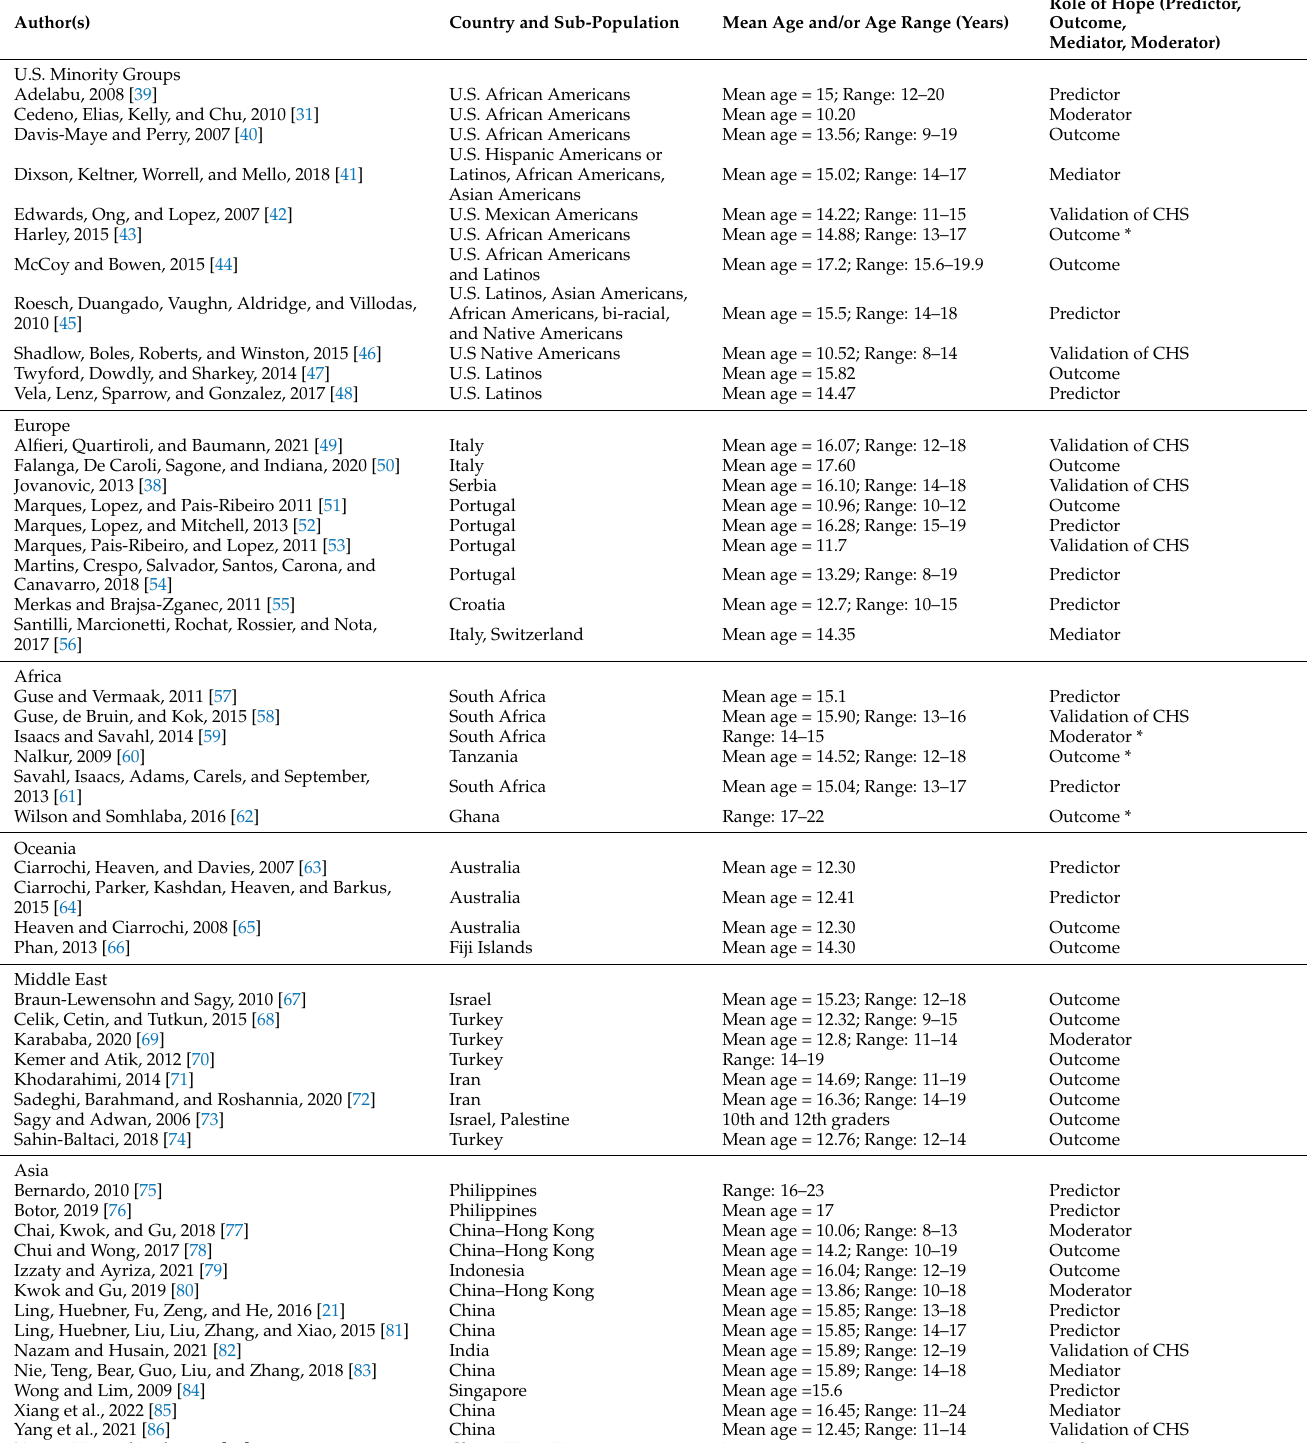
Table 1. Organization of the literature of hope in adolescence by world